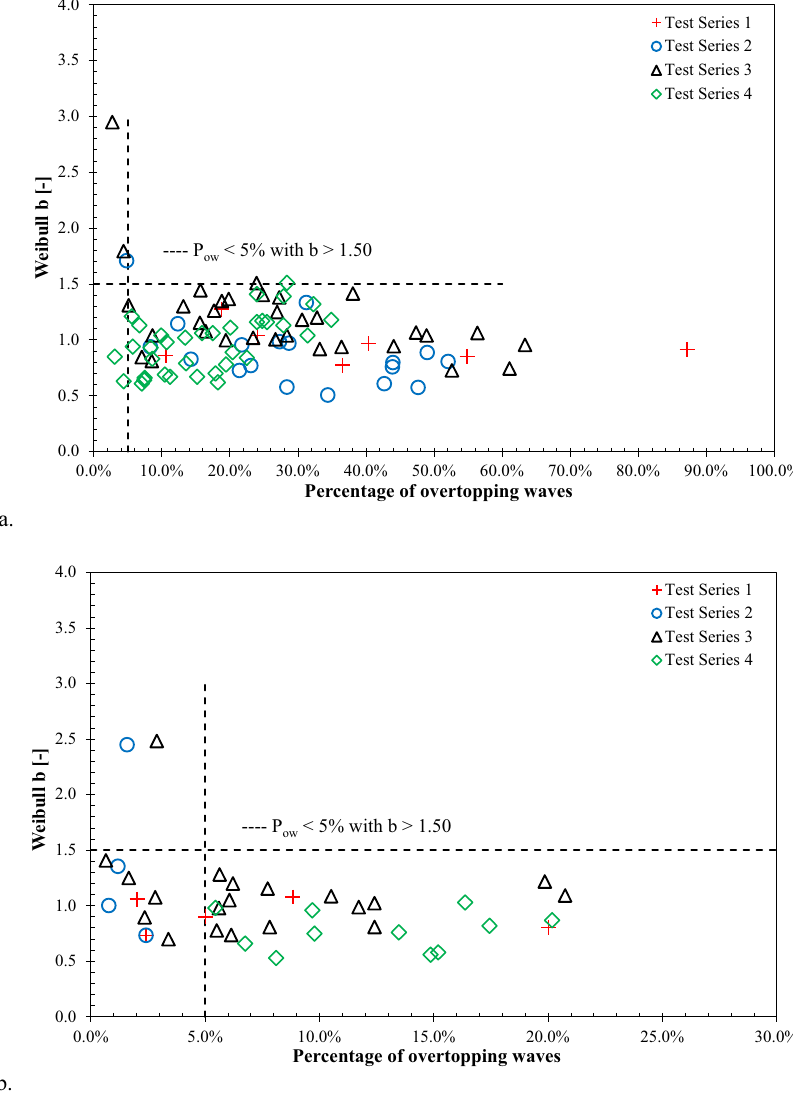
Figure 4. Influence of overtopping waves probability on the Weibull b parameters: (a) impulsive wave conditions, and (b) non-impulsive wave